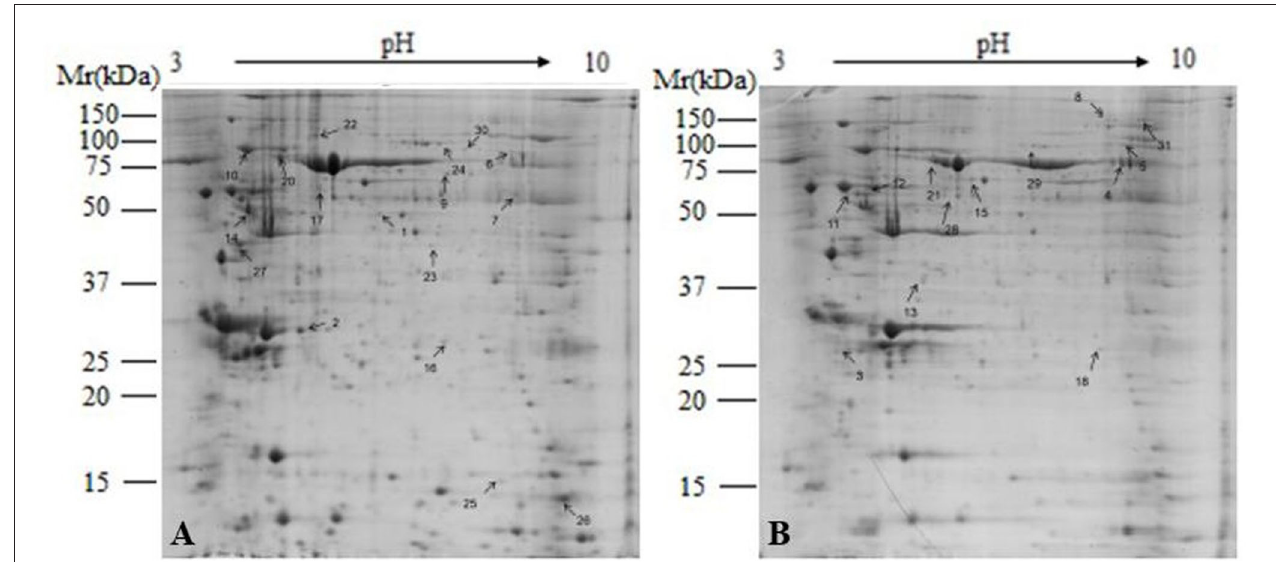
FIGURE 5 | Representative 2-DE images of proteins extracted from lactating goat mammary. (A) High-grain group; (B) Buffering agent group. Equal amounts of protein (1,000mg) were loaded onto the 17cm IPG gel strip (non-linear, pH 3.0–10.0), and separated on 17-cm IPG strips (pH 3.0–10.0), followed by electrophoresis on 12.5% SDS-PAGE gels for second dimension electrophoresis. Black arrows indicate differential protein spots ( ≥